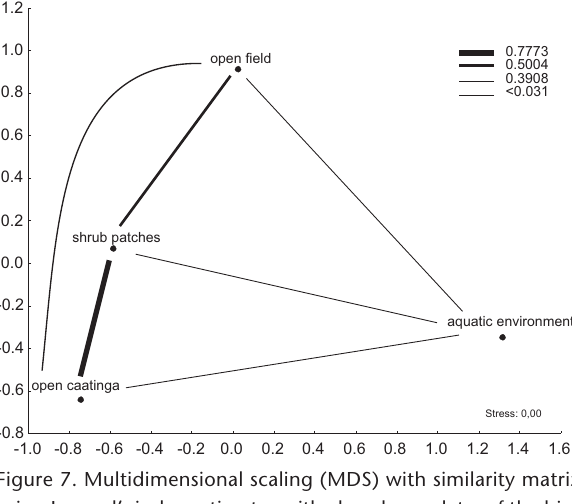
Figure 7. Multidimensional scaling (MDS) with similarity matrix using Jaccard’s index estimates with abundance data, of the bird species composition in the each habitat. The thickness of the lines indicates the similarity values that are demonstrated in the